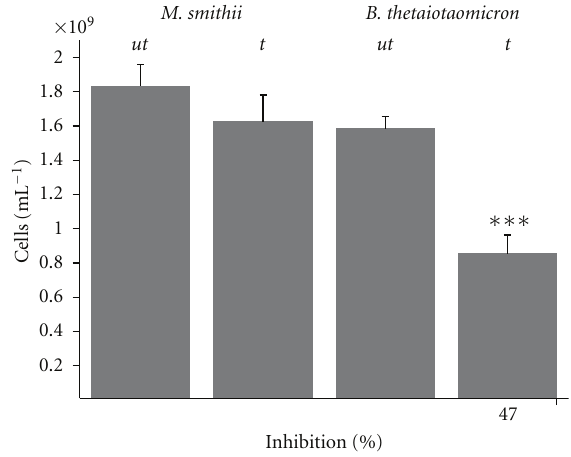
Figure 4: Reduction of the cell counts of B. thetaiotaomicron due to the production of volatile TMBi produced by M. smithii ( n = 3). M. smithii and B. thetaiotaomicron were grown in the coculture system. CBS was applied at a concentration of 80 µ M to the culture of M. smithii in its late exponential phase. The TMBi production of M. smithii , during its 48h incubation in the presence of CBS, results in a significant cell count reduction of B. thetaiotaomicron cultures ( t ) compared to untreated control ( ut